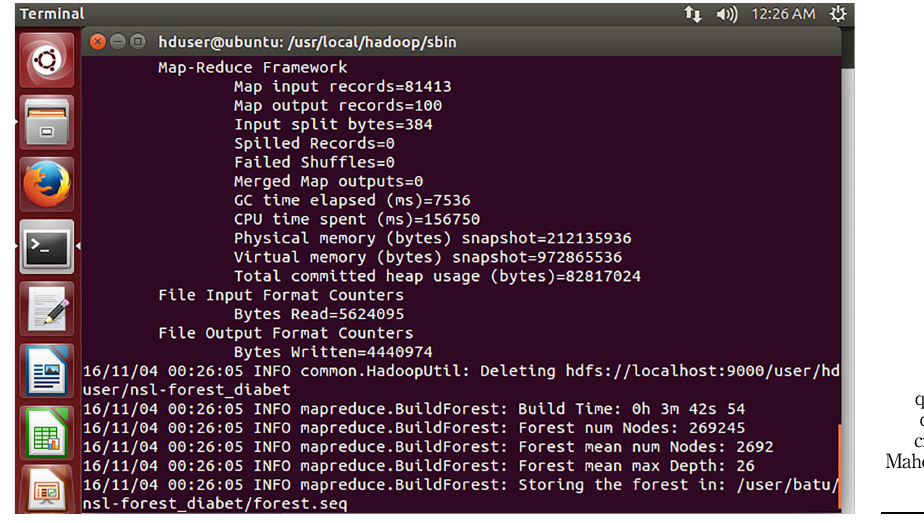
Figure 2. Time spent, byte quantity, node and depth count of the created tree for the Mahout random forest training